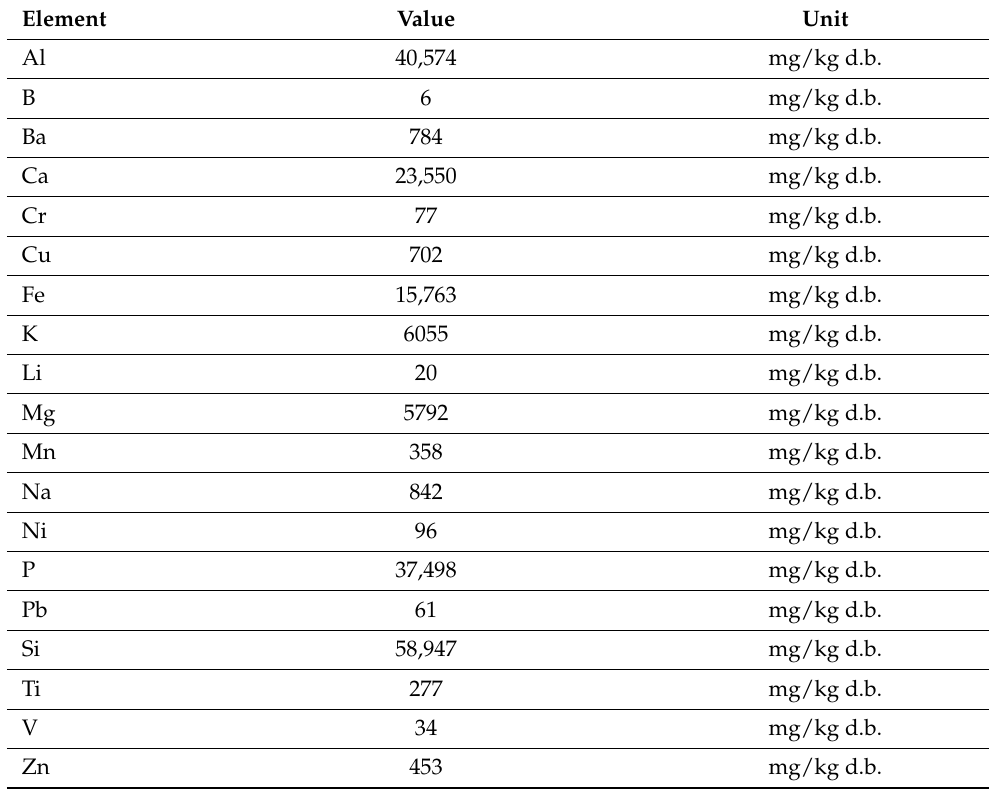
Table 3. Elemental composition of the feedstock (sewage